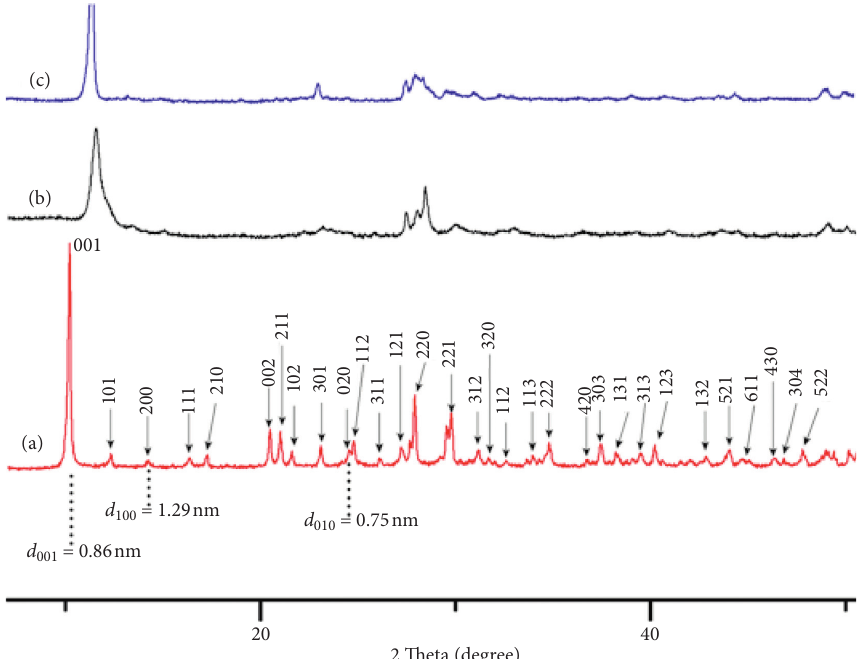
Figure 4: XRD patterns of (a) LEuH-Cl aggregates, (b) LEuH-flocs nanosheets, and (c) LEuH-flocs +fluoride ions.